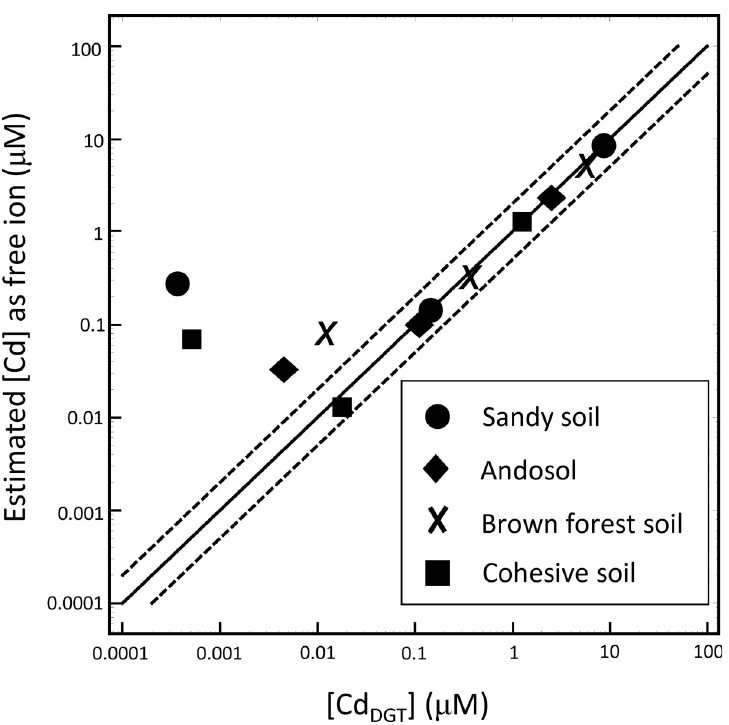
Fig 7. Comparison of observed [Cd] as [Cd DGT ] and estimated free [Cd] for samples S-1, A-1, B-1 and C-1 by the ligand model. Dashed lines show a factor of 2.